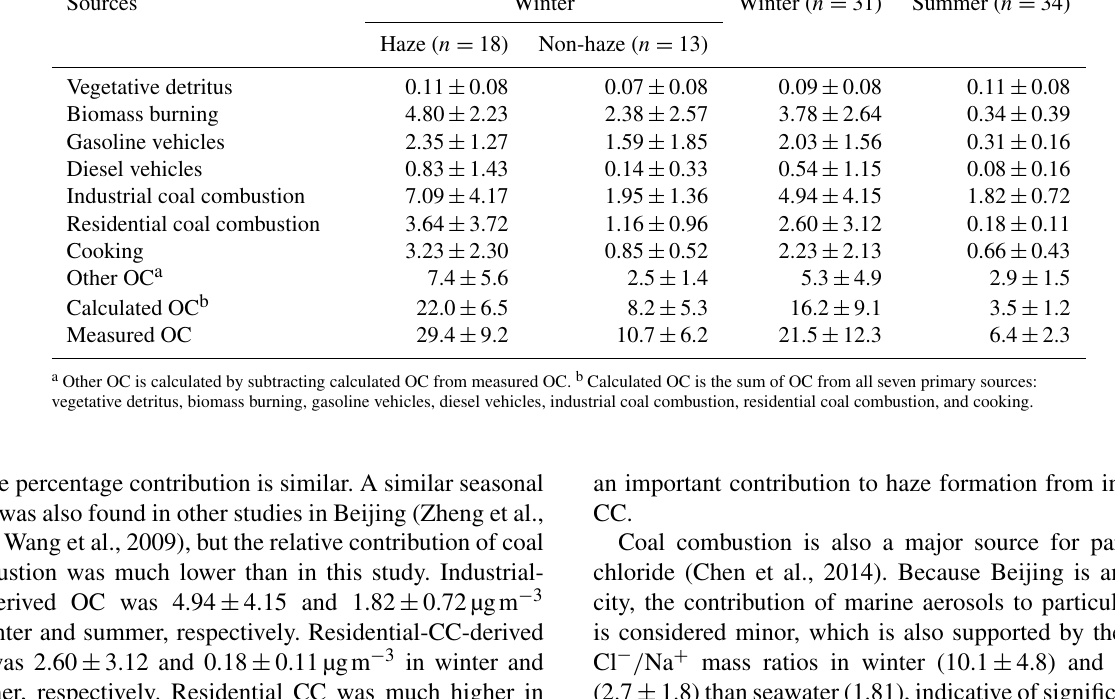
Figure 3. Regression results between reconstructed PM 2 . 5 and offline and online PM 2 . 5 by chemical mass closure method. Table 2. Source contribution estimates (SCEs; µgm − 3 ) for fine OC in urban Beijing during winter and summer from the CMB model. Sources Winter Winter ( n =